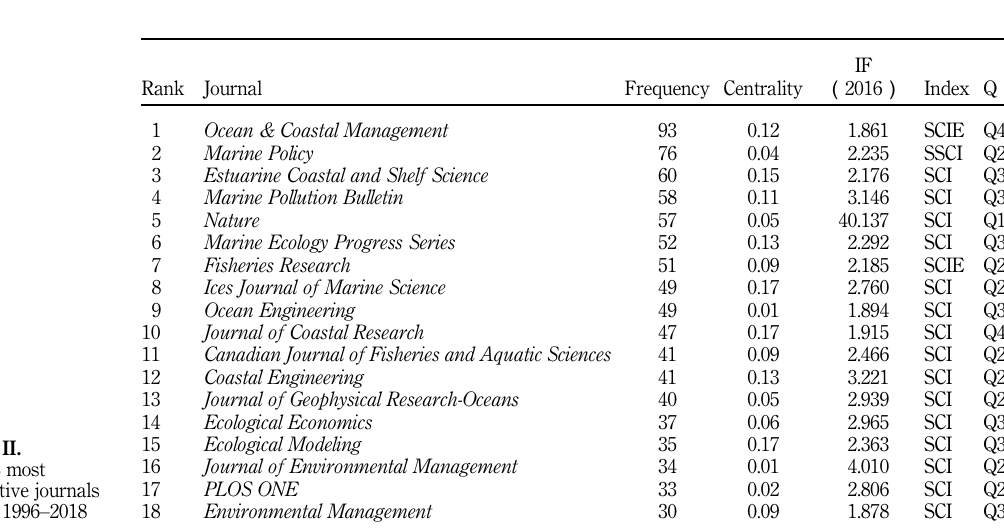
Figure 9. Distribution charts of published journals published in marine econometrics